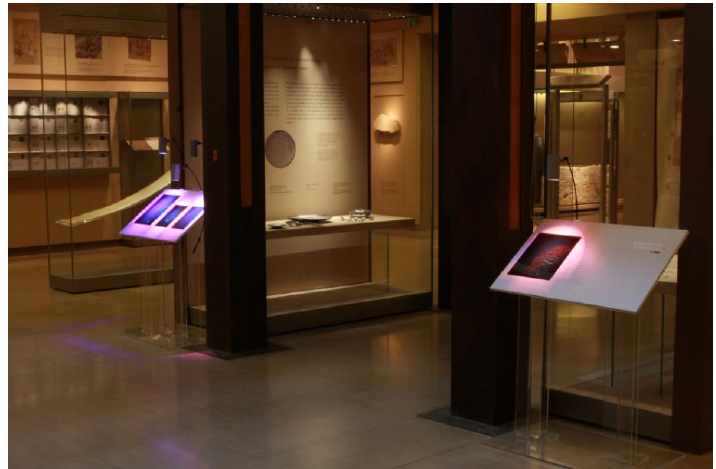
Figure 8. Display stands with OptoClones TM and HoLoFoS TM illumination, Byzantine and Christian Museum of Athens (BXM), June 2014 (HiH, 2014).